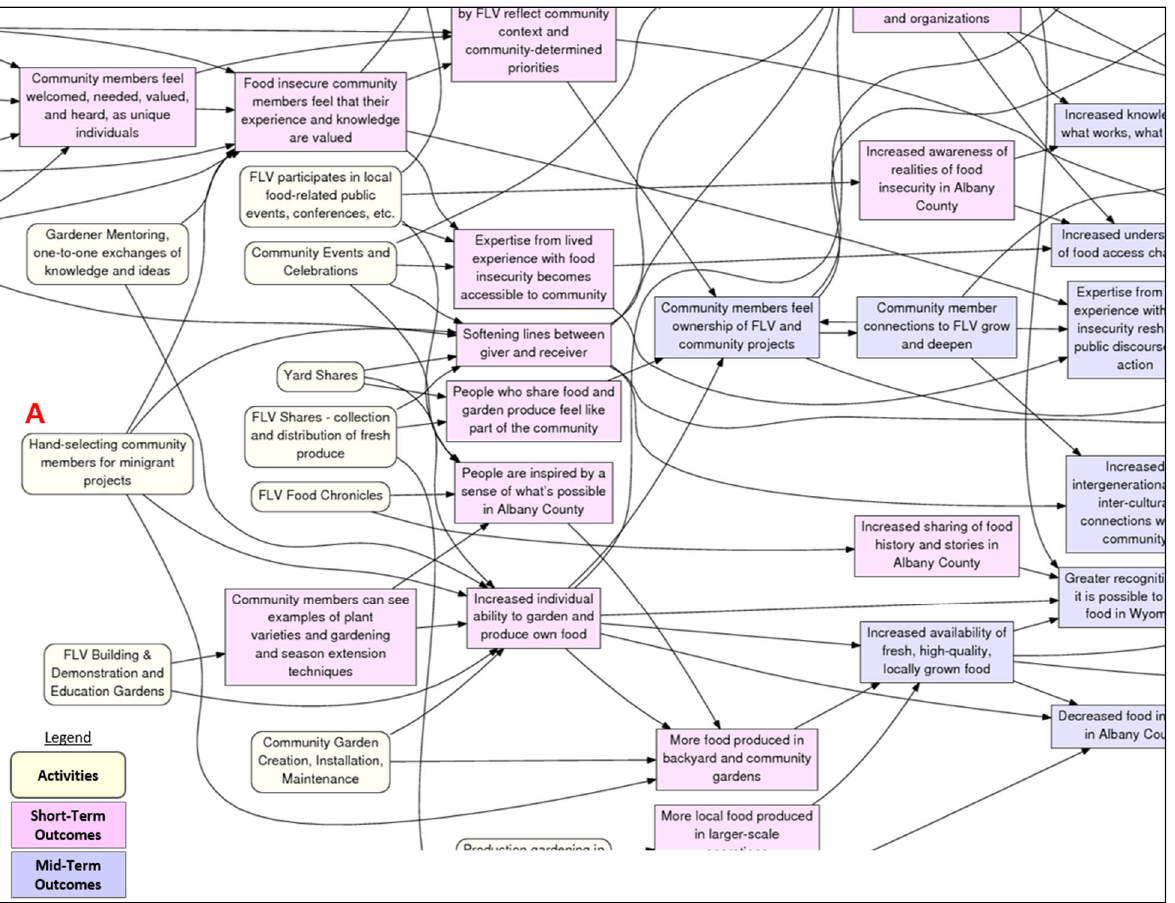
Figure A3. Subsection of Feeding Laramie Valley (FLV)’s Collaborative Pathway Model Relating to